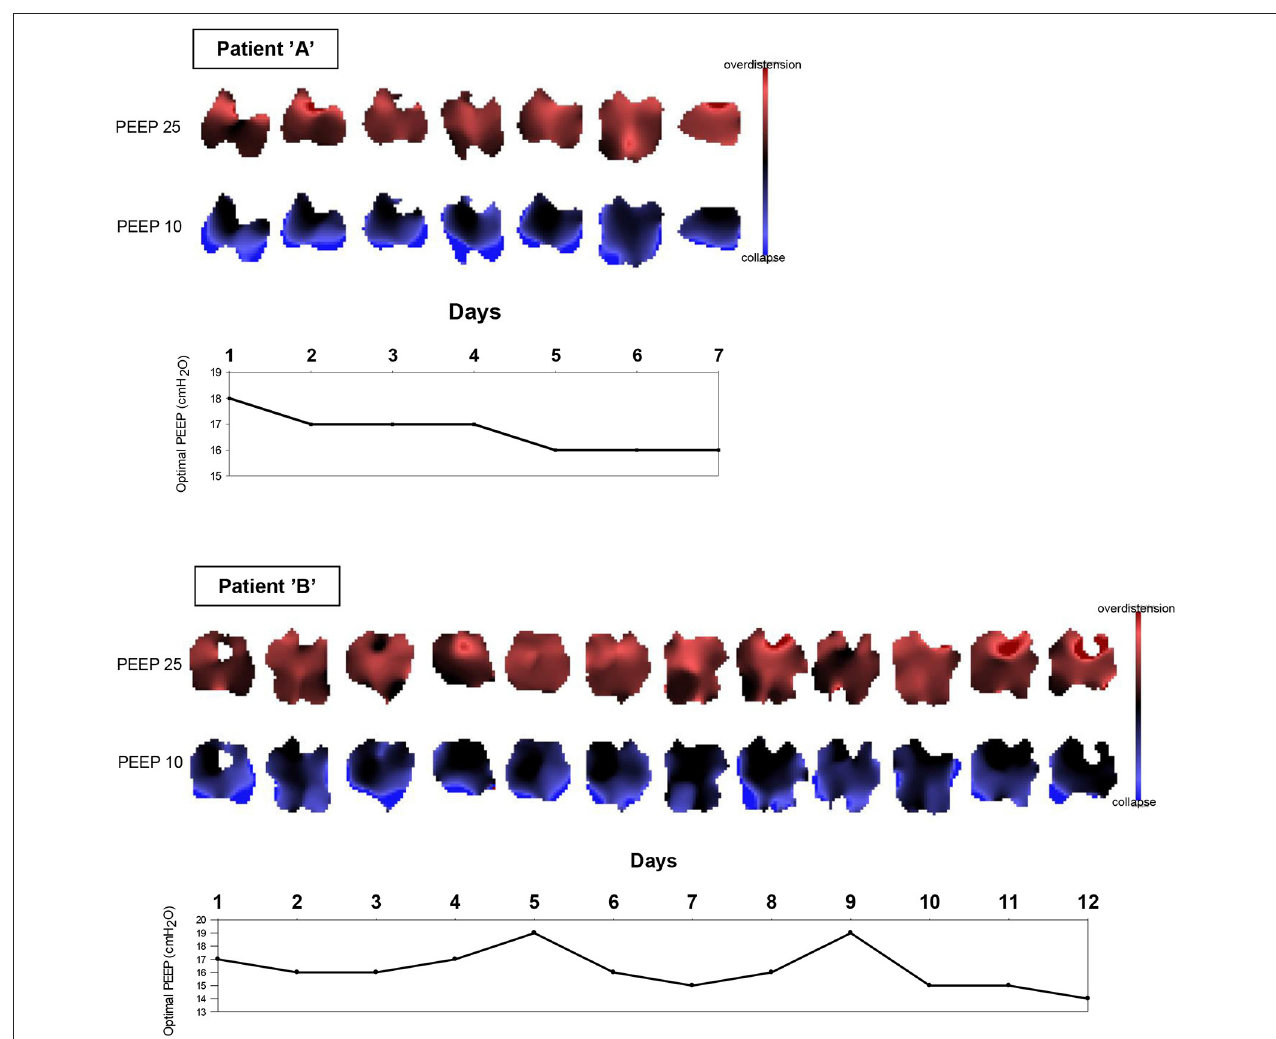
FIGURE 5 | Pixel overdistension and collapse images on each day with patients (A,B) at top PEEP 25 and final PEEP 10 cmH 2 O and optimal PEEP levels. PEEP, positive end-expiratory